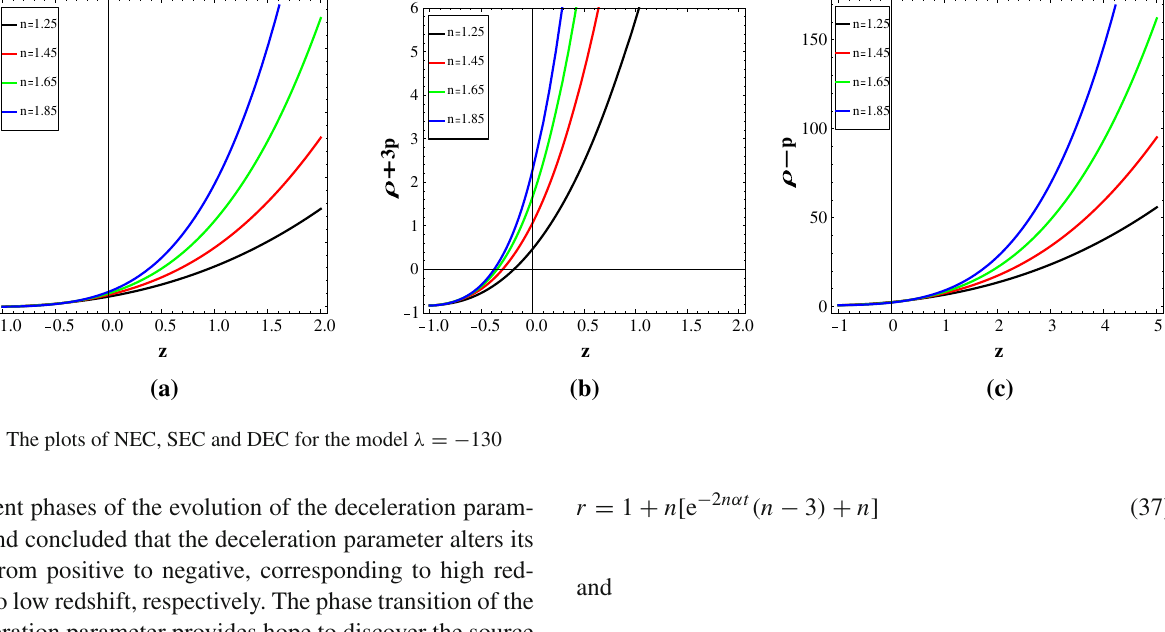
Figure 7a represents the time evolution of four trajectories for different values of n in r – s plane. All the trajectories corresponding to different values of n evolve with time but deviate from the point SCDM, i.e., { r , s } = { 1 , 1 } , which corresponds to a matter dominated Universe. The directions of the r – s trajectories in the plane diagram are represented by arrows. Initially, we have examined that cases corresponding to n = 1 . 25 and n = 1 . 45; the trajectories remain in the domain r < 1 , s > 0, which relate our dark energy model to the quintessence model. Also trajectories corresponding to n = 1 . 65 and n = 1 . 85 start evolving from the region r > 1 , s < 0, which resembles the behavior of dark energy with a Chaplygin gas and this region is highlighted by CG in the top leftmost part of the plot. The downward pattern of trajectories representing the CG behavior and the upward trend of the trajectories representing quintessence behavior are eventually met at the point { r , s } = { 1 , 0 } , i.e., we have the (cid:3) CDM model. This suggests that our model behaves like (cid:3) CDM in the late time of cosmic evolution. In addition we havepresentedonemorehorizontallineintheabovediagram, which shows the transformation of trajectories from a matter dominated Universe SCDM to (cid:3) CDM as time unfolds. The } on the horizontal point having coordinates { r , s } = { 1 , 2 3 linerepresentstheholographicdarkenergymodelwithfuture event horizon as IR cut-off labeled as H DE in Fig. 7a, begins } and ultimately the evolution from the point { r , s } = { 1 , 2 3 ends its evolution at (cid:3) CDM [102–104]. Therefore, the plot of { r , s } for our model is effectively discriminant among other dark energy model for different n